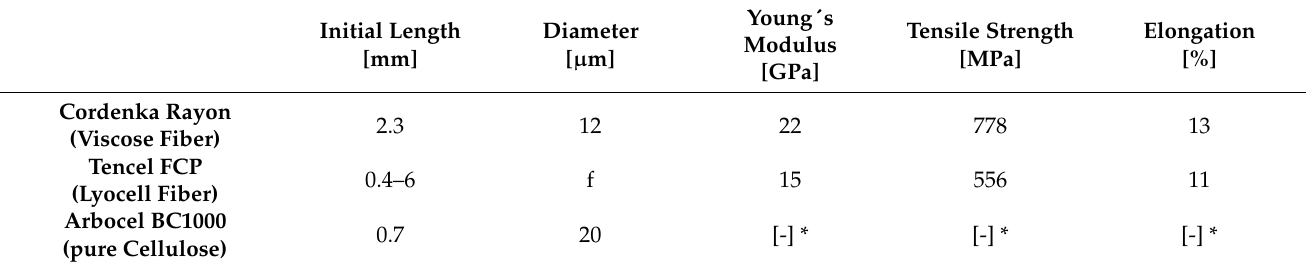
Table 1. Lengths and mechanical properties of different cellulosic fibers